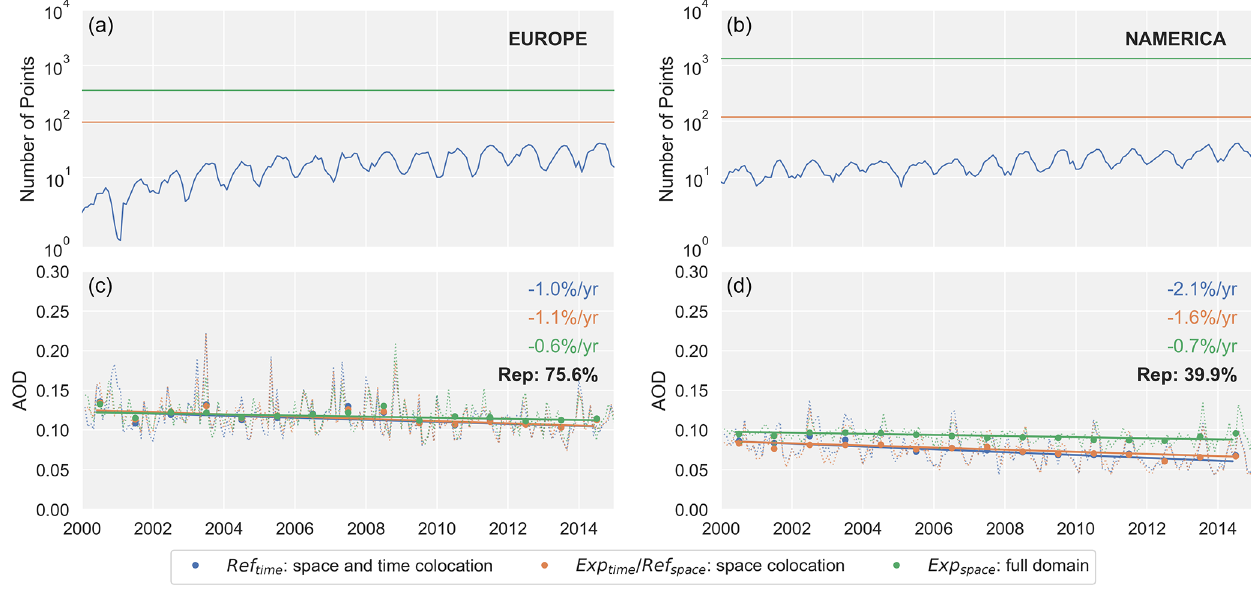
Figure 4. Three regional AOD time series and respective trends, constructed from model data (NorESM2) for the investigation of the representativity of the observational data. Panels (a) and (b) correspond to the number of points used to compute the regional time series for the three different datasets. Panels (c) and (d) show the time series, the trends and the resulting representativity value (black, bold). The blue color (Ref time ) corresponds to the model output co-located in space and time with the available observations. Panels (a) and (b) show an overall increase in the number of available observations (more stations) combined with a seasonal cycle (less AOD available in wintertime). The orange color (Exp time / Ref space ) corresponds to the model output co-located in space with the stations providing measurements, using the complete time series from 2000 to 2014. The green color (Exp space ) corresponds to the model output in the whole geographic region (see Fig. 2), using all of the grid boxes without any co-location with the observations. Table 3. Observational mean values for the year 2000, the reference year used for computing relative trends. Each value is extracted as the intercept of the linear trend computed in the 2000–2014 period, except for σ sp and σ ap , where the trends have been computed over 2000–2018. Because the required minimum number of yearly averages was set to seven, no trend could be computed in the southern African region. Europe North America South America North Africa Asia Australia AOD 0.17